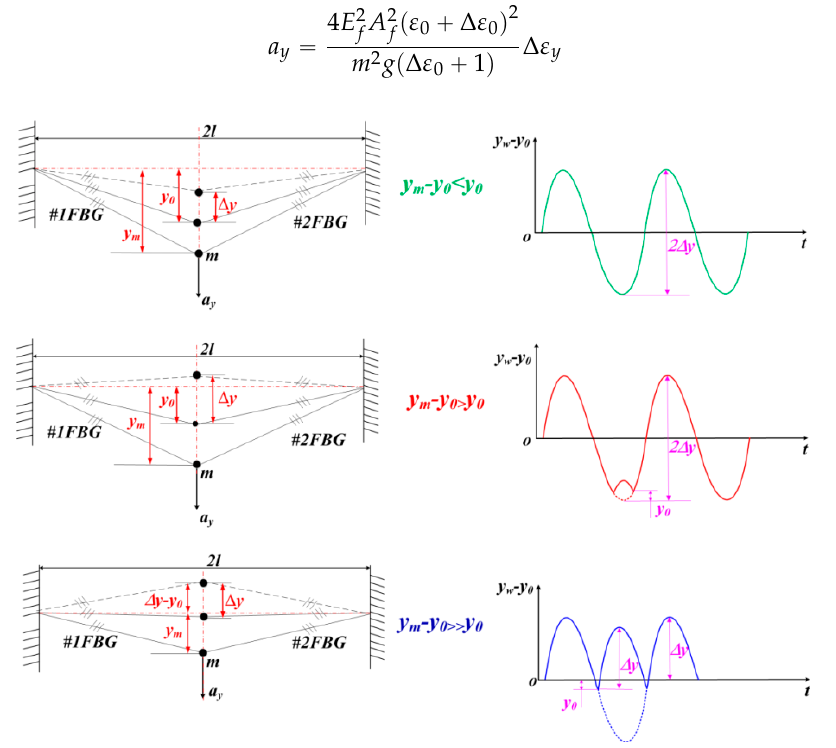
Figure 3. Response wave pattern for vertical vibration model of optical fiber.